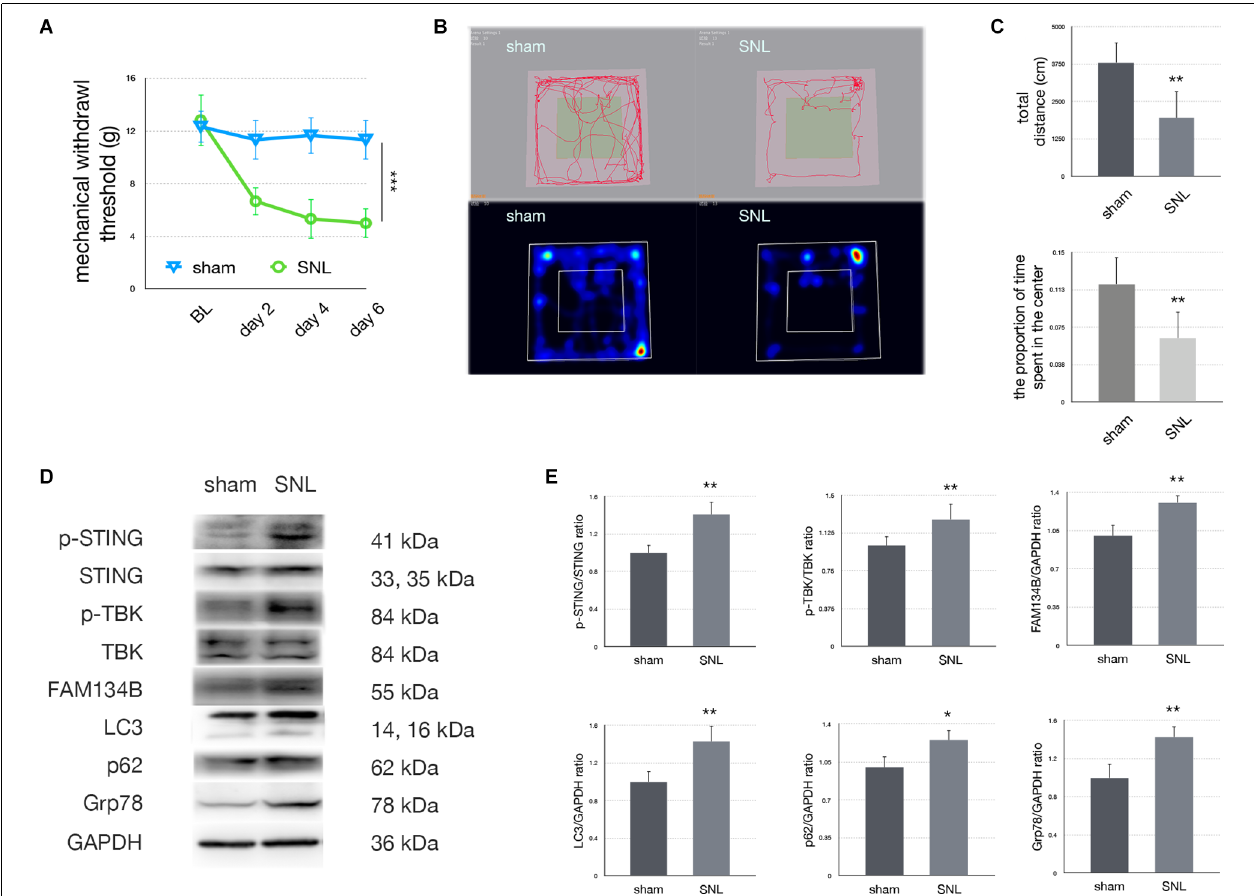
FIGURE 2 | Spinal nerve ligation activated the STING/TBK pathway. (A) Mechanical withdrawal threshold in sham vs. SNL groups (two-way ANOVA, P < 0.001). (B) Trace map and heat map of the open field test in sham vs. SNL groups. (C) Quantification of the open field test (one-way ANOVA, total distance: F = 16.781, P = 0.002; proportion of time spent in the center: F = 12.512, P = 0.005). (D) Western blotting in sham vs. SNL groups. (E) Quantification of immunoblotting in sham vs. SNL groups (one-way ANOVA, p-STING/STING: F = 16.75, P = 0.002; p-TBK/TBK: F = 10.786, P = 0.008; FAM134b/GAPDH: F = 19.265, P = 0.001; LC3/GAPDH: F = 10.756, P = 0.008; p62/GAPDH: F = 8.957, P = 0.014; Grp78/GAPDH: F = 10.897, P = 0.008). N = 6 rats per group, * P < 0.05 compared with the sham group; ** P < 0.01 compared with sham group; *** P < 0.001 compared with sham group. Abbreviations: SNL, spinal nerve ligation; sham, sham operation of spinal nerve ligation; BL,